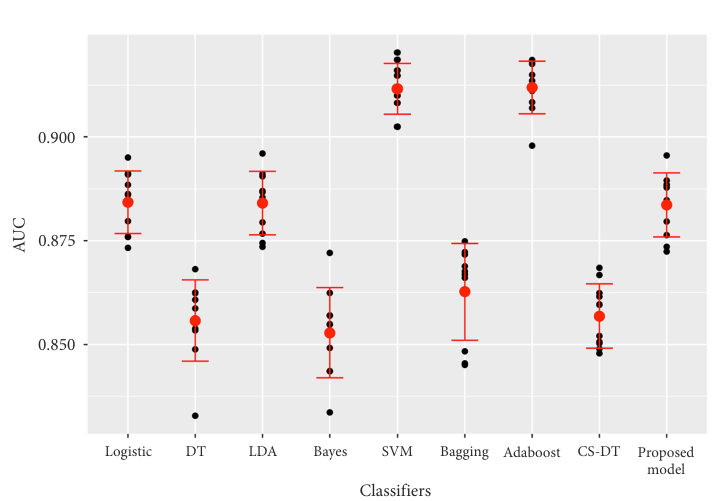
Figure 8. Total cost box plot